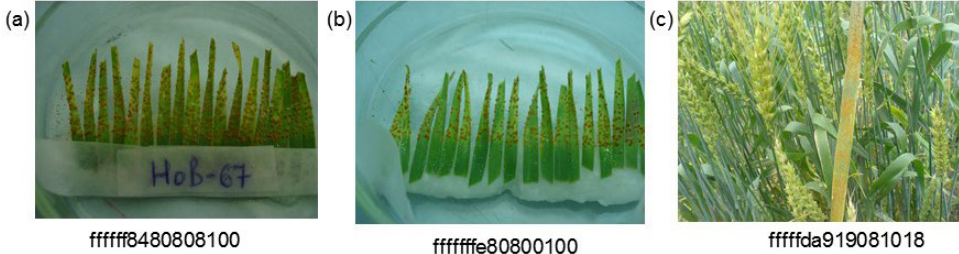
Figure 5. Examples of images of wheat leaves and shoots affected by leaf rust. Below the image, there are the file names (hash function values), which are similar for similar images ( a , b ) but differ significantly for different images ( a , c ) and ( b , c ).